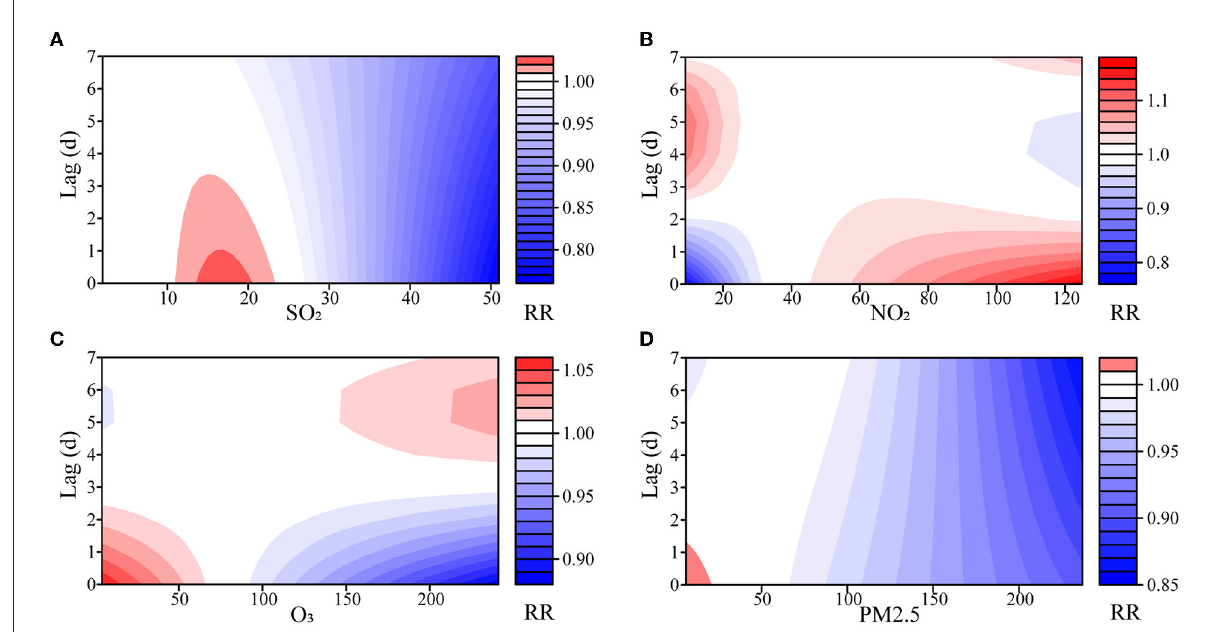
FIGURE2 Exposure–lag–response association of meteorological factors and air pollutants on outpatients with psoriasis. (A) SO 2 , sulfur dioxide; (B) NO 2 , nitrogen dioxide; (C) O 3 , ozone; (D) PM 2.5 , fine particulate